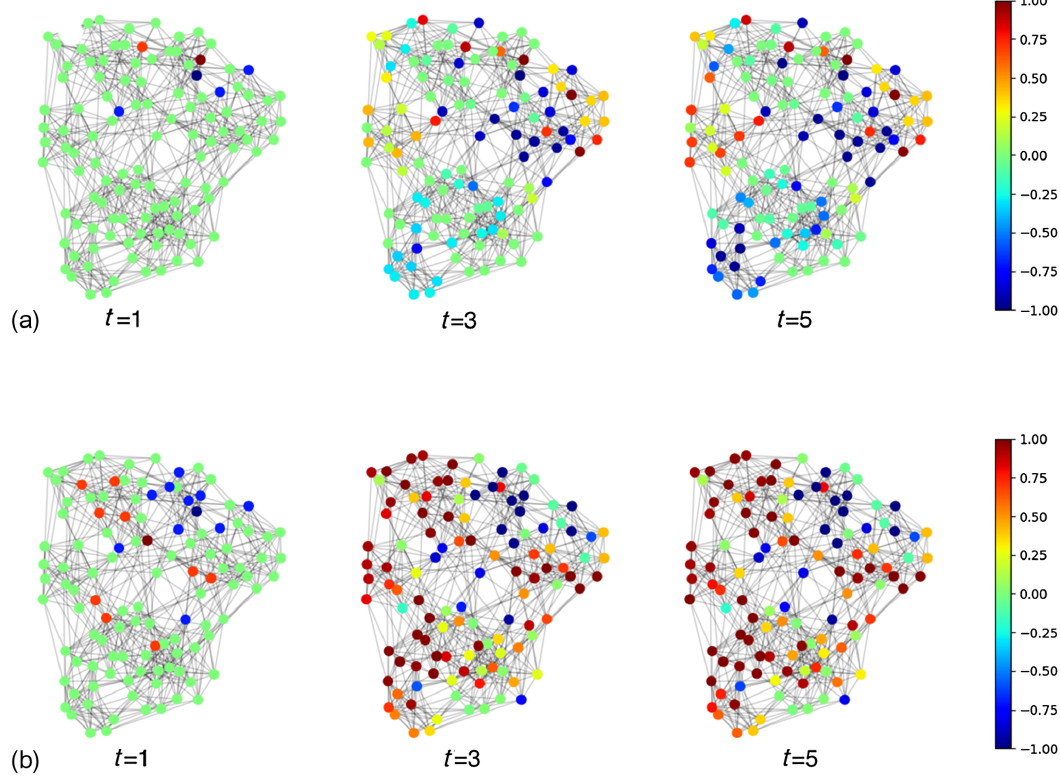
FIG. 6. Football network with infection parameters α A ¼ α B ¼ 0 . 7 . The budget for B is 1, allocated on node 1 at t ¼ 0 , and a budget of 1 per time step is optimally assigned for process A . The figures represent the containment of process B at different times t ¼ 1 ; 2 ; … ; 5 due to the judicious allocation of resources of process A . (a) DMP-greedy strategy; (b) DMP-optimal strategy. The heat bar represents the dominating process per node through the value P i A ð t Þ − P i B ð t Þ . Red and blue represent dominating processes A and B ,